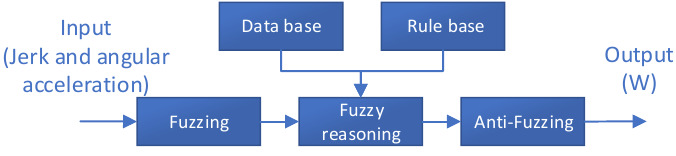
Figure 4. Basic logic diagram of fuzzy logic control.